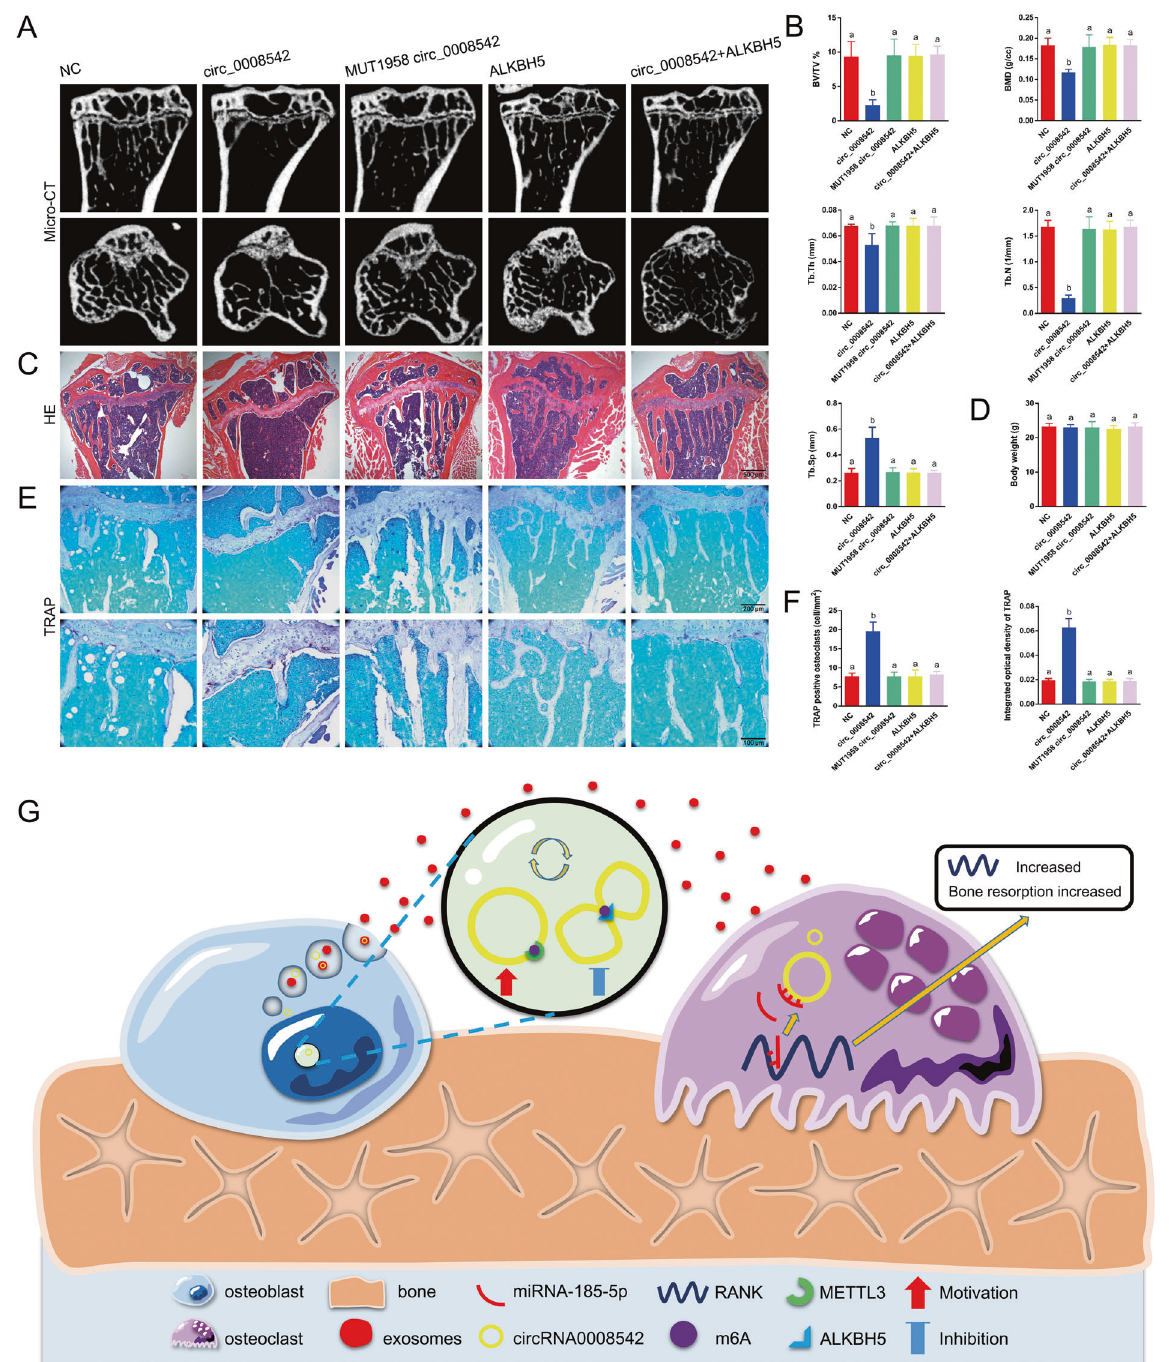
Fig. 6 The effects of circ_0008542 in vivo. Circ_0008542, MUT1956 circ_0008542, or ALKBH5 was transfected into MC3T3-E1 cells and collected from cell supernatant exosomes separately or simultaneously according to the different groups. A , C After 8 weeks of exosome injection, micro-CT, and H&E staining were applied to measure the bone histological parameters. B , D Histograms of BV/TV, BMD, Tb.Th, Tb.N, Tb.Sp, and body weight among the fi ve groups. E TRAP staining was applied to evaluate the osteoclast differentiation and bone resorption ability. F Histograms of TRAP positive osteoclast number and integrated optical density of TRAP among the fi ve groups. G Schematic diagram of this study. Data were representative of fi ve independent experiments expressed as the mean ± SD. Different letters (a and b) indicate signi fi cant differences among multiple groups ( p <